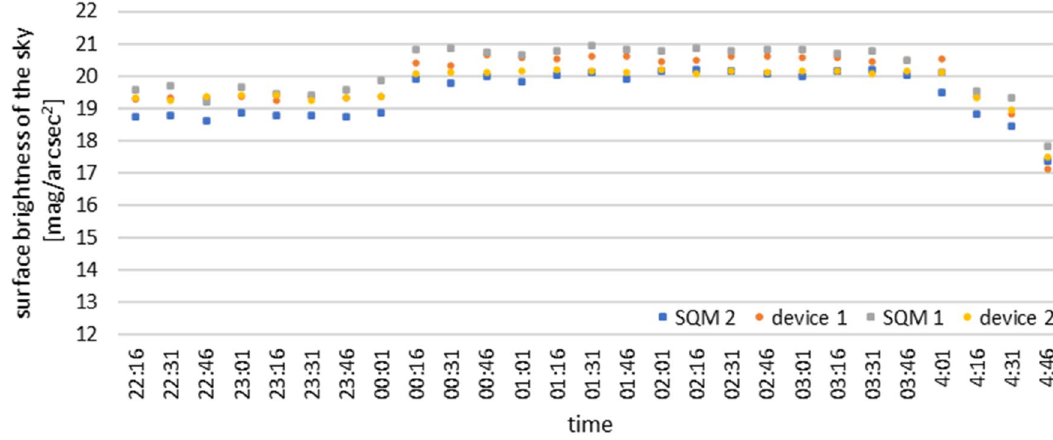
Figure 4. Comparison of the measurement results obtained by a device of its own design with the measurements made by SQM photometer (27–28.03.2020).